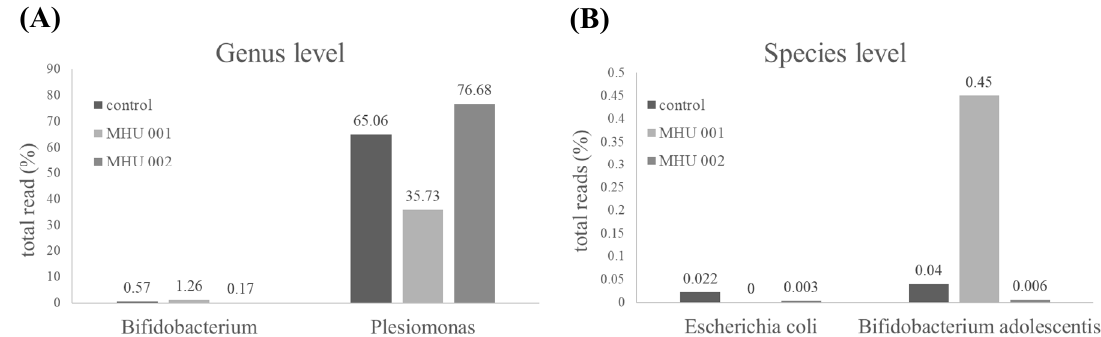
Figure 5. Changes in the distribution of bacteria in the zebrafish gut after feeding soybean tempeh for 2 weeks. Genus level ( A ), and species level ( B ), respectively. Control: normal diet; MHU 001: fed with soybean tempeh fermented with MHU 001; MHU 002: fed with soybean tempeh fermented with MHU 002.